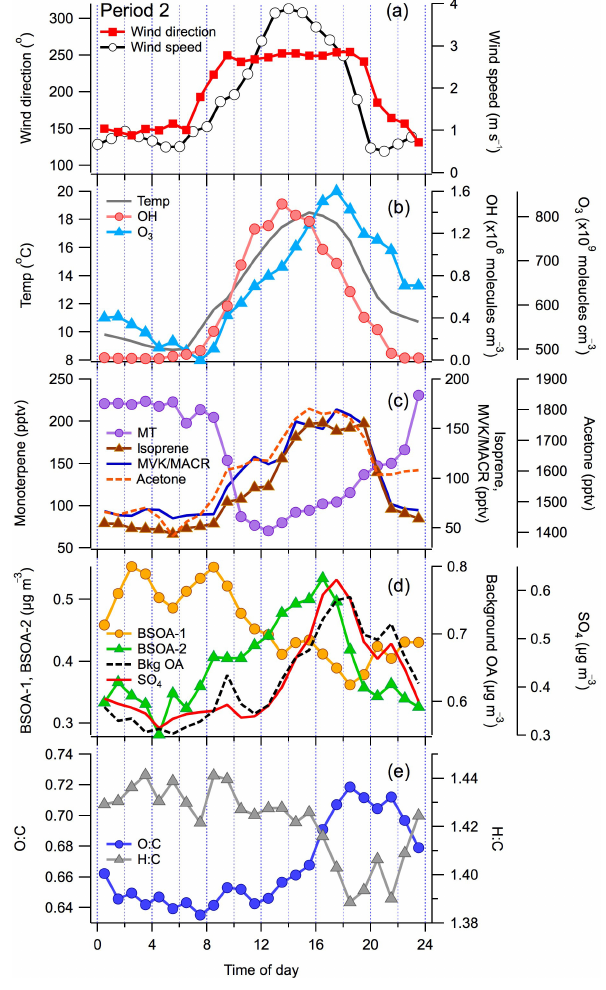
Figure 4. Diurnal cycles of (a) temperature, OH radical and ozone (b) monoterpene (MT), isoprene, methyl vinyl ke- tone (MVK)/methacrolein (MACR), and acetone, (c) background OA, BSOA-1, BSOA-2 and SO 4 , and (d) elemental compositions of total organics (O:C and H:C) observed during 13–18 July (Pe- riod 2). Note that the OH radical concentration is the average value measured after 19